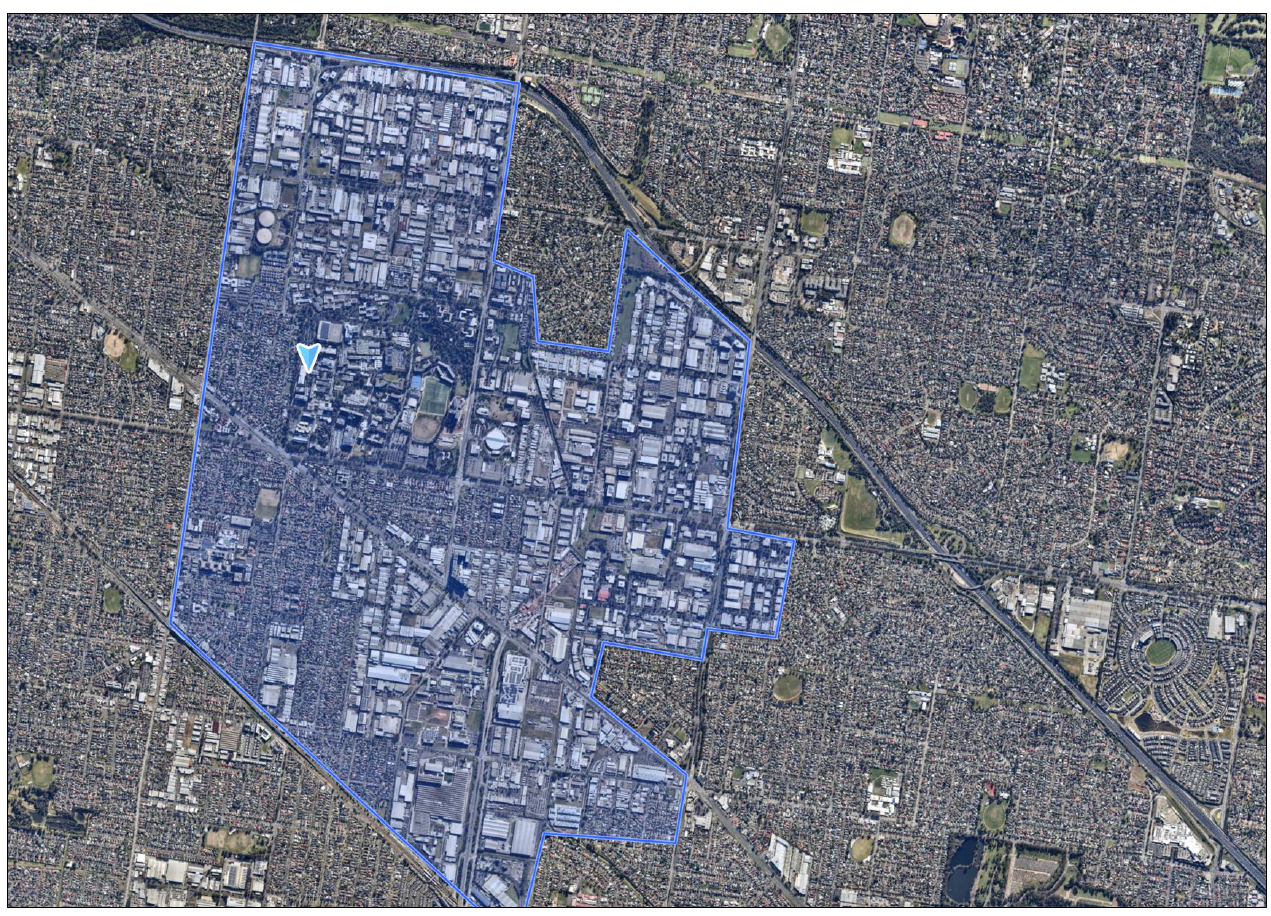
Figure 3. Location of Monash Technology Precinct.